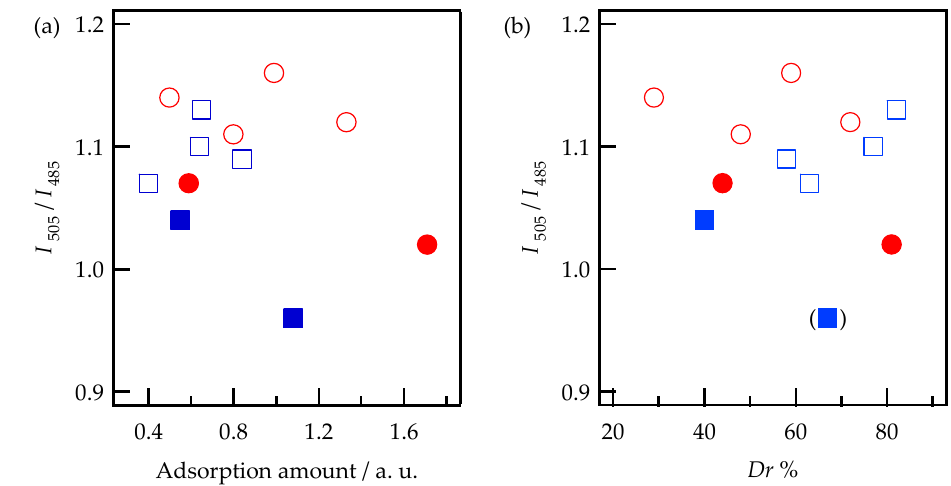
Figure 11. A ratio between the fluorescence peak intensities at 505 nm and 485 nm ( I 505 / I 485 ) plotted against ( a ) the relative adsorbed amount and ( b ) desorption fraction ( Dr %) of Alq 3 ( □ ) and h-Alq 3 ( ○ ) species on the APA surface (the unfilled and filled points correspond to electropolishing and degreasing pretreatment, respectively). The symbol ( ■ ) denotes the results obtained for the APA sample (v).